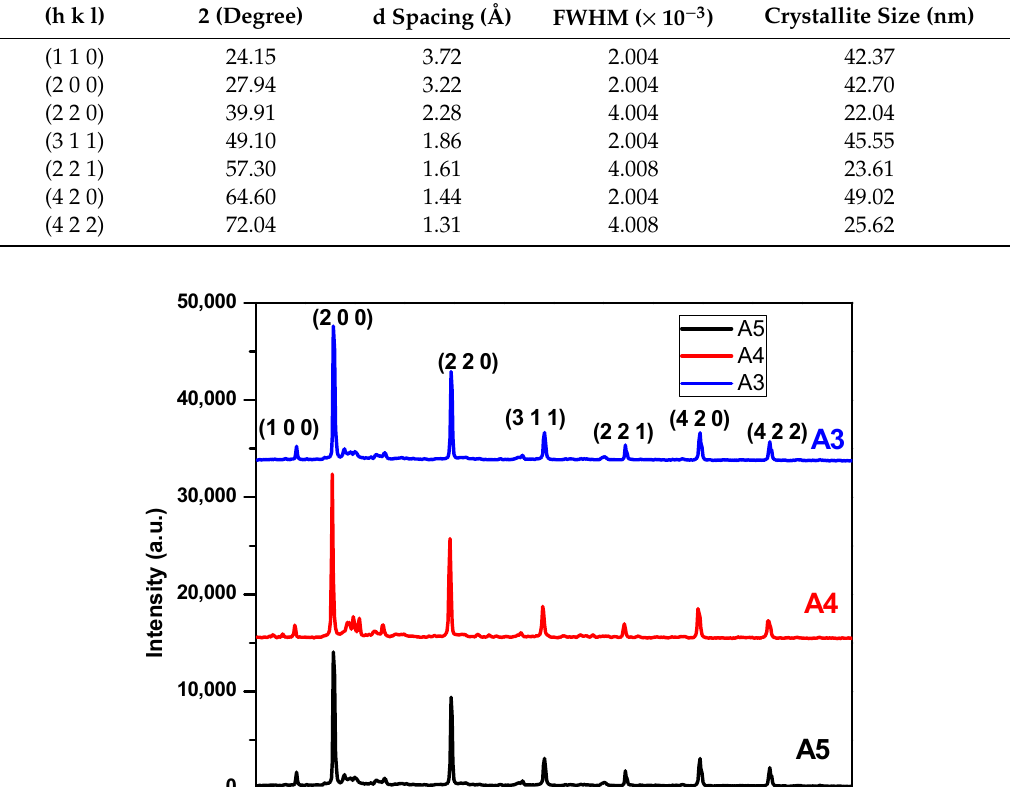
Table 1. X-ray diffraction ( XRD) analysis of the PbTe powder for sample A4.